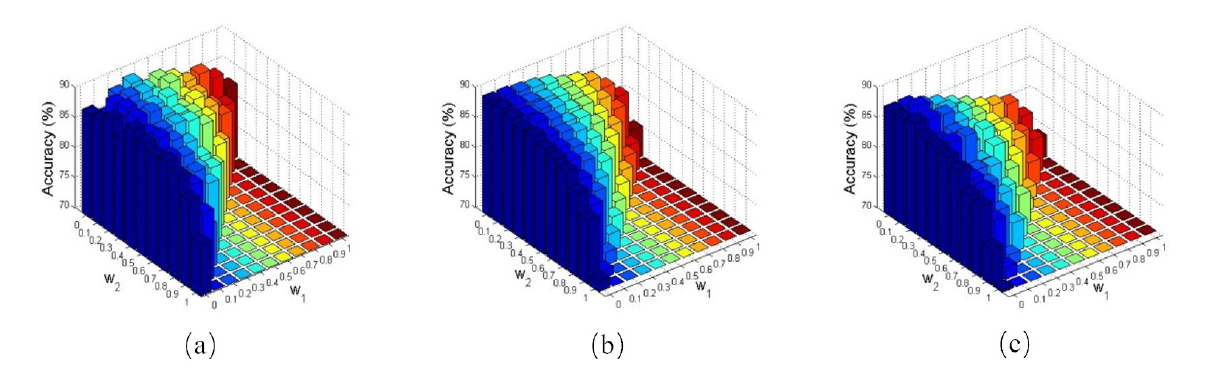
Figure 7. The average identification accuracy rates of the proposed method versus different values of weighted parameters on the ( a ) CASIA, ( b ) IITD, and ( c ) GPDS